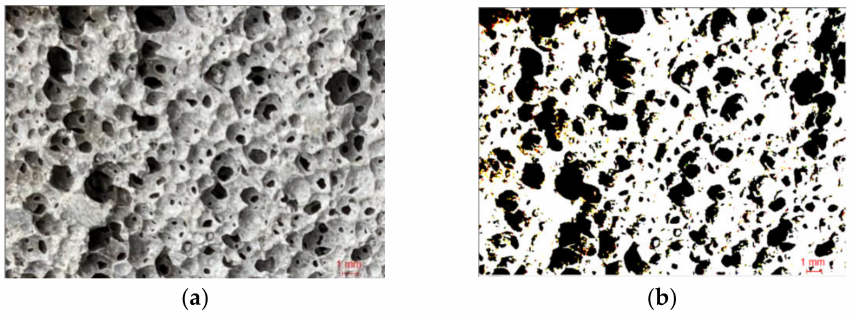
Figure 2. Section diagrams of the foamed concrete; ( a ) original image; ( b ) processed